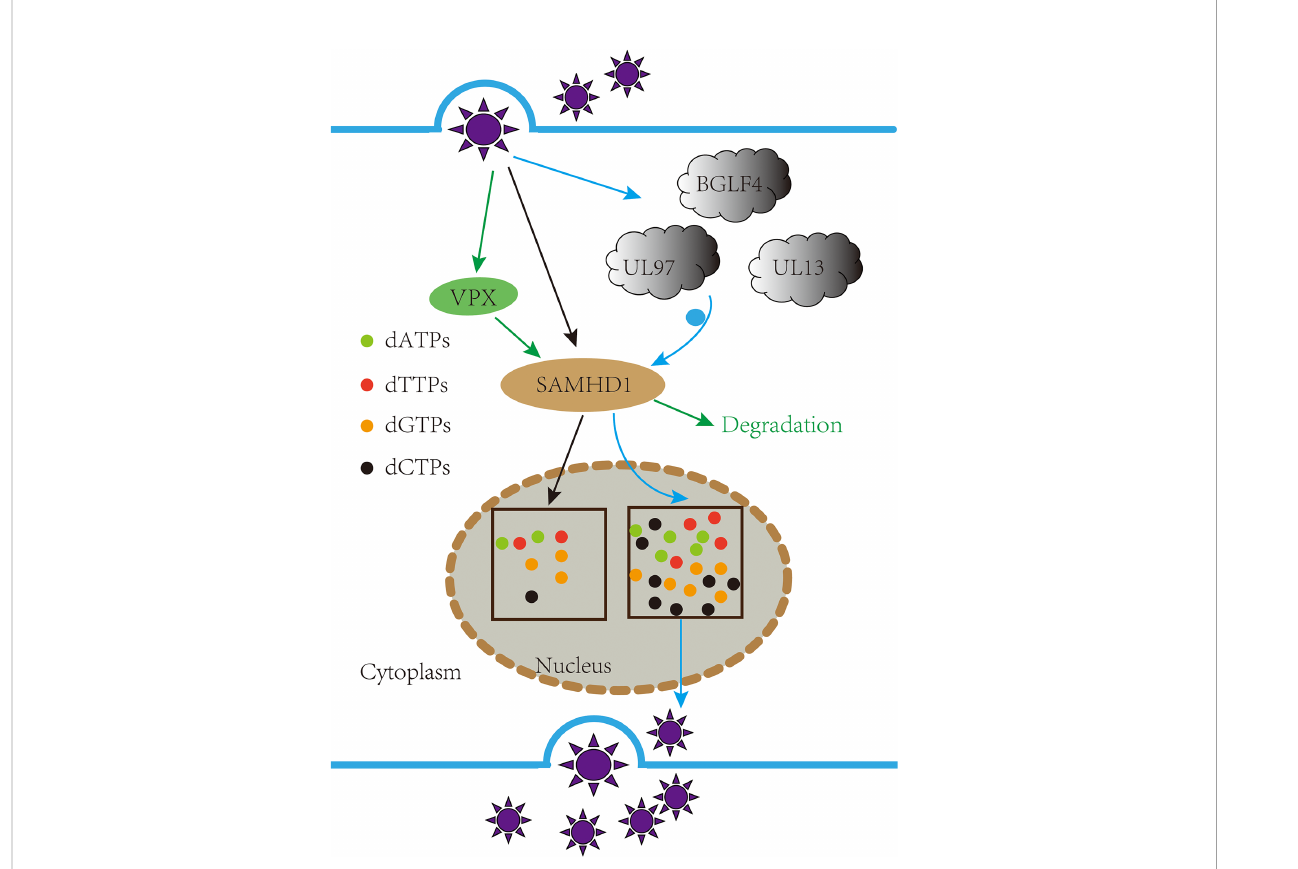
FIGURE 3 pUL13 phosphorylated the antiviral factor SAMDH1 Thr592 to promote viral replication. Inhibiting the dNTP enzyme activity of the sterile alpha motif and HD domain-containing protein 1 (SAMHD1) from ensuring adequate intracellular levels of dNTPs for viral